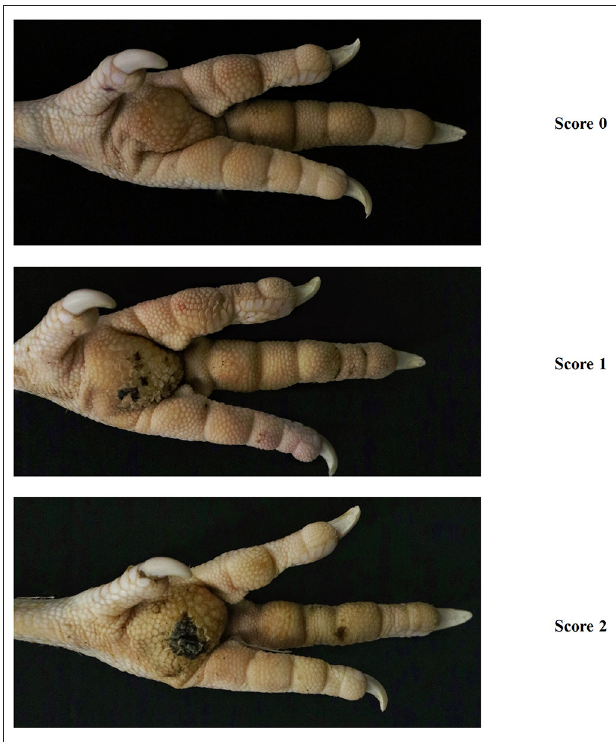
FIGURE 1 | Photographs of foot lesions from turkeys at slaughter used as visual descriptions in the footpad dermatitis (FPD) scoring